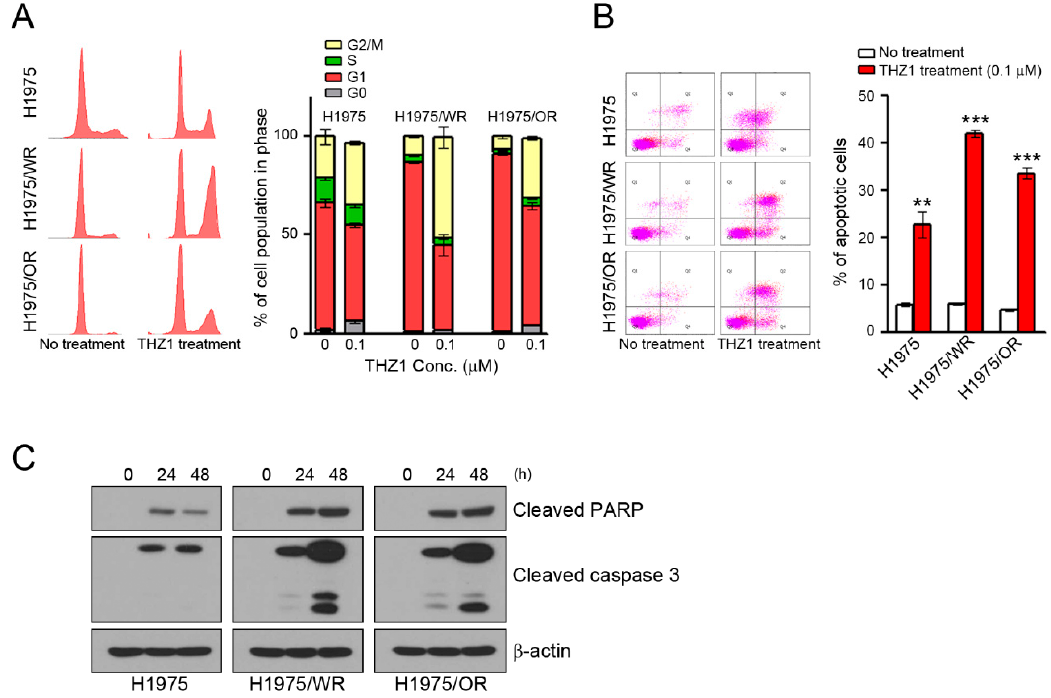
Figure 4. Induction of cell cycle arrest and apoptosis by CDK7 inhibitors in parental and resistant cells. ( A , B ) Cells were treated with THZ1 for 24 or 48 h to analyze the cell cycle and apoptosis. The cell cycle was determined by propidium iodide (PI) staining, and apoptosis was determined by Annexin V-FITC and PI. The experiment was conducted in triplicate. ( C ) Cells were treated with 0.1 µ M THZ1 in a time-dependent manner. Cleaved PARP and caspase-3 were detected by western blotting. ** P < 0.005; *** P < 0.0005 compared to the control group.